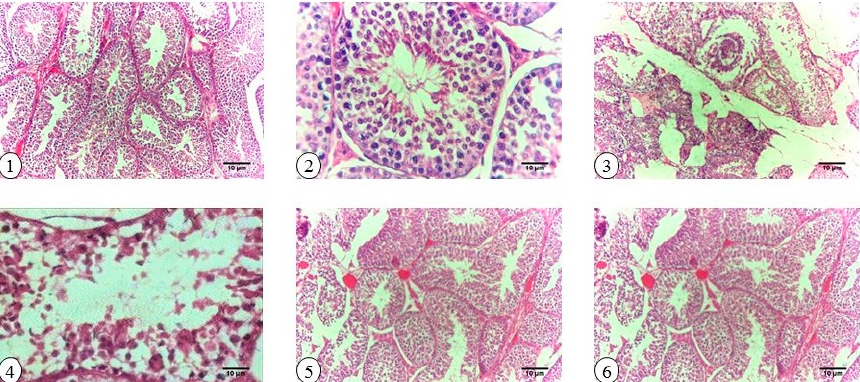
Figure 7. Cross sections of histopathological examination of testicular samples in Control, Diabetic, Diabetic + TQ, and TQ-treated groups stained with H&E. ( 1 ) Control group rats show intact seminiferous tubules and regular spermatogenesis and active Leydig cell, 100×. ( 2 ) Control group rats show free spermatozoa in the lumen of the seminiferous tubules, regular spermatogenesis, and active Leydig cell, 400×. ( 3 ) Diabetic rats show apparent degeneration of the seminiferous tubules, sperm giant cell, and pyknotic spermatocytes, 100×. ( 4 ) Diabetic rats show sloughing of the germinal epithelium, lysis of the spermatocytes, and necrosis of the spermatids, 400×. ( 5 ) TQ-treated diabetic rats show resuscitation of the seminiferous tubules’ enhancement (100×) in the tubular basal compartment with the presence of spermatogonia. ( 6 ) TQ rats show normal seminiferous tubules, 100×. TQ; thymoquinone.